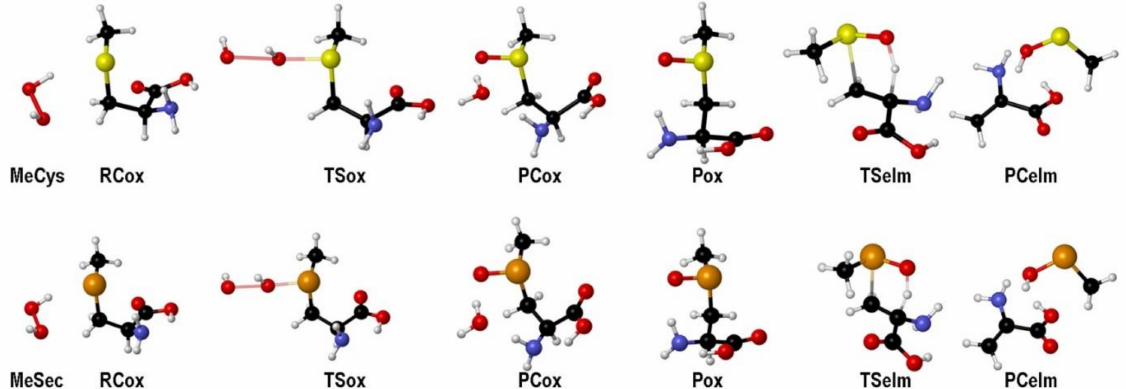
Figure 4. Stationary points along the oxidation mechanism of MeCys/MeSec by H 2 O 2 (see Scheme 14) and subsequent elimination. Adapted from [90].